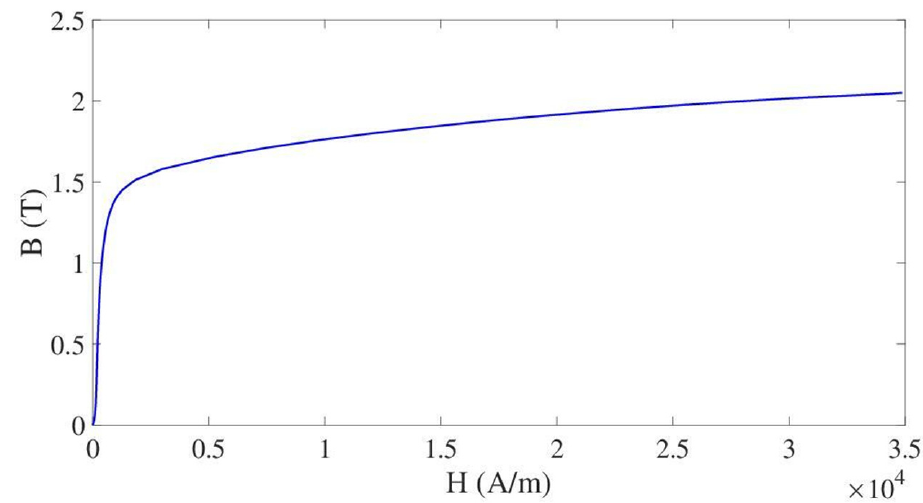
Figure 1. Initial magnetization curve of Q195 low-carbon steel . The specimens were cut from a 3 mm plate of ferromagnetic Q195 low-carbon steel and annealed to reduce the residual stress by heating them at 650 ◦ C for 2 h and then allowing them to cool naturally in the furnace. The dimensions of the specimens are shown in Figure 2. The surface magnetic signals were detected using an array probe in the middle of the specimen, occupying an area of 30 mm × 30 mm. The X-axis is along the long axis of the specimen, and the Y-axis is perpendicular to the X-axis.